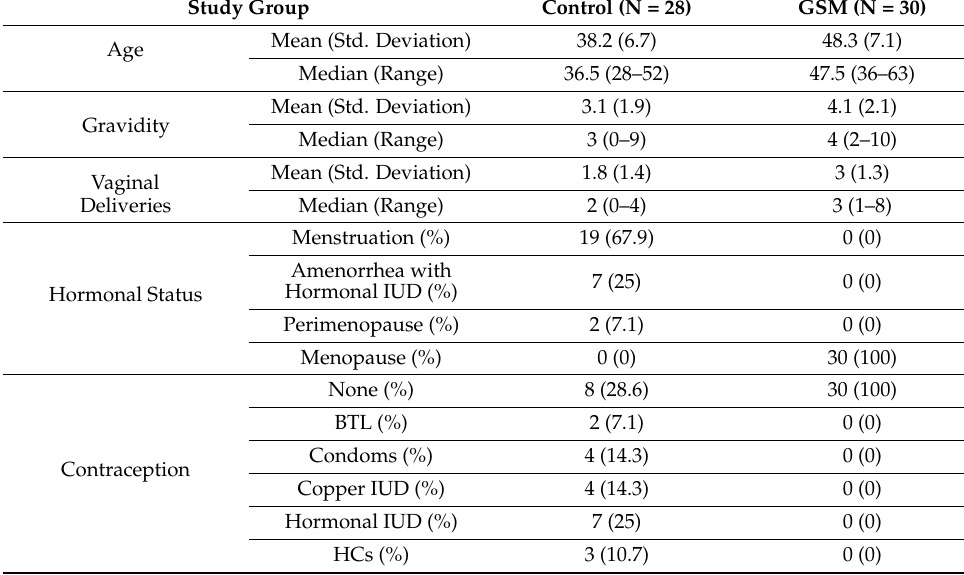
Table 2. Patients’